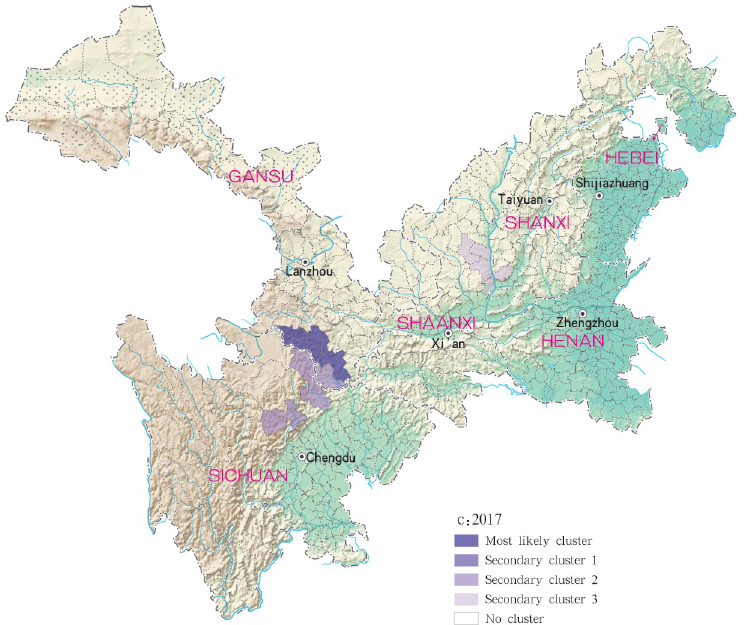
Fig 18. Spatial clustering analysis of mountain-type zoonotic visceral leishmaniasis incidence in 6 provinces, China in 2017.